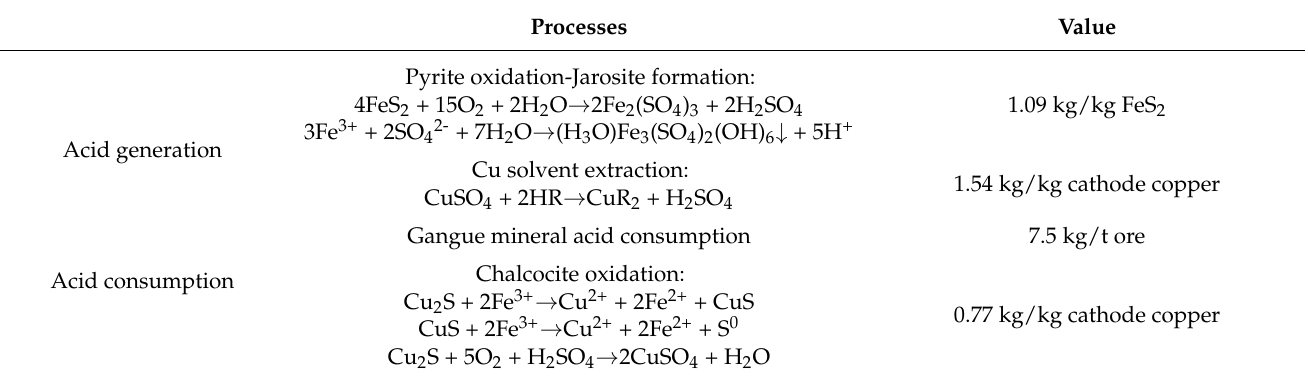
Table 2. Main processes on acid generation and consumption during heap bioleaching of Letpadaung ore. Processes Value Pyrite oxidation-Jarosite Acid generation